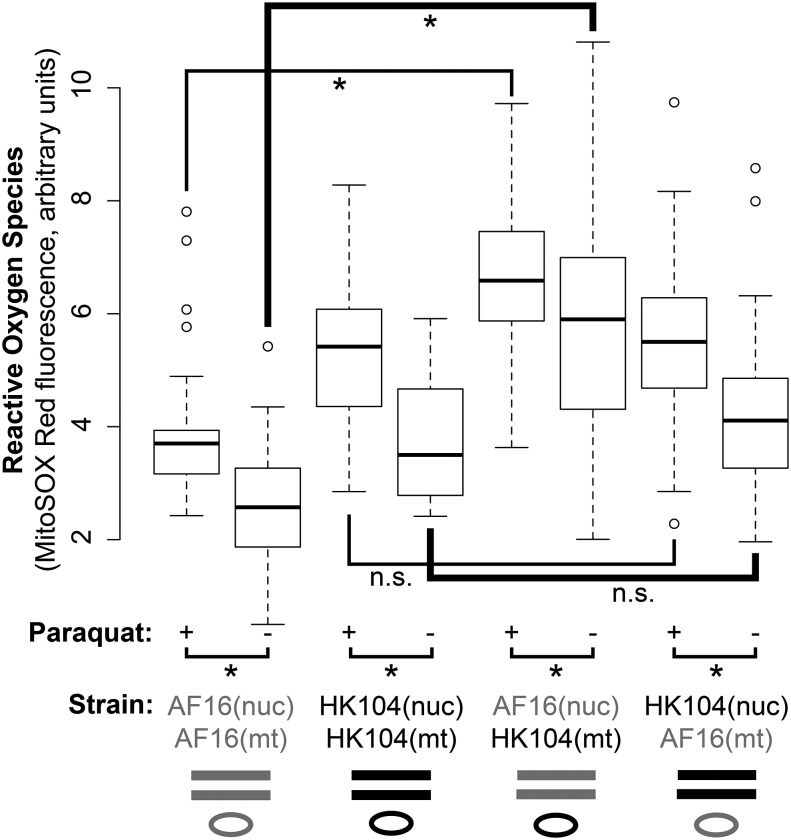
Comparison of parental and cybrid reactive oxygen species (ROS) levels. Boxplot of in vivo ROS measured by MitoSOX Red fluorescence. Horizontal brackets within the plot denote four statistical comparisons made between cybrids and their P0 paternal strains (*P < 0.05, n.s. not significant; Bonferroni-corrected unpaired two-tailed t-test). The cybrids with AF16 nuclear and HK104 mitochondrial genotypes exhibit significantly higher ROS levels than AF16 both in the absence (–) and the presence (+) of ROS-inducing paraquat. For every strain, the presence of paraquat significantly increases ROS levels (four horizontal brackets beneath the plot). Different thicknesses of the lines denoting statistical comparisons are for clarity.